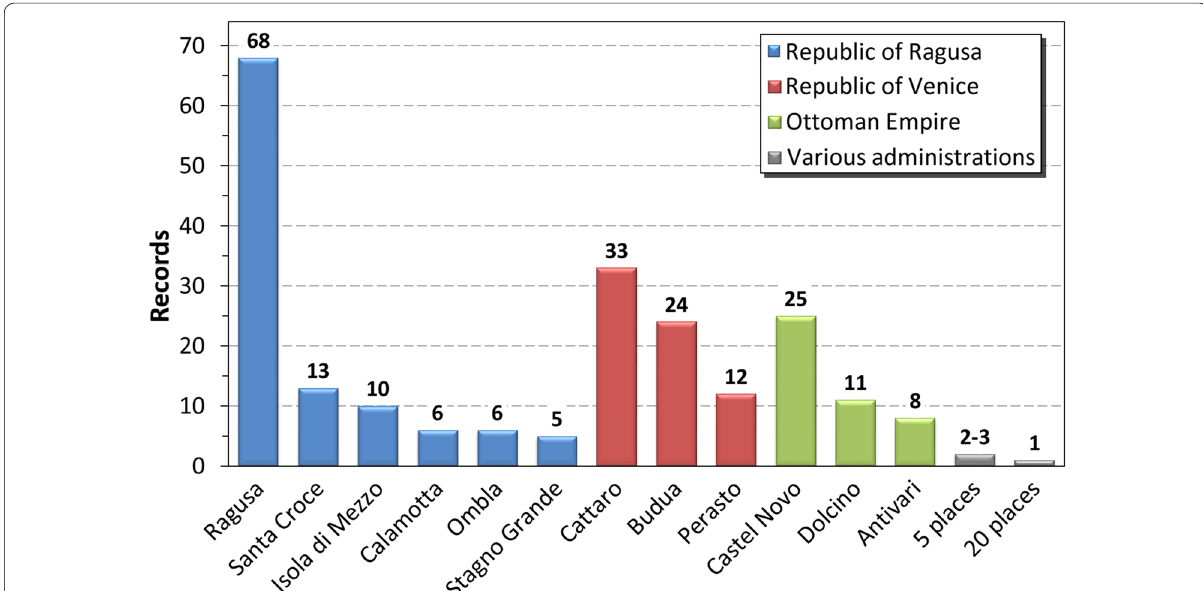
Fig. 5 Amount and pertinence of 253 earthquake records for 37 settlements in the area of the 6 April 1667 earthquake. From Albini (2015), modi- fied